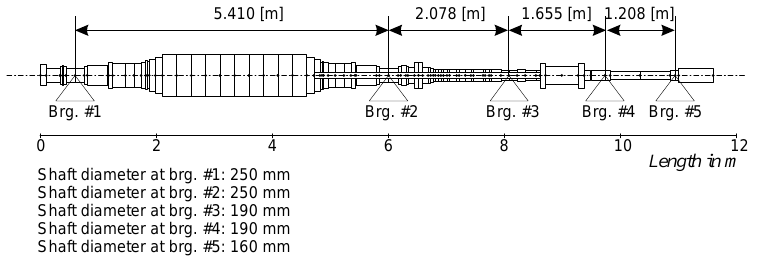
Fig. 4. Draft of the rotor-train: generator (between brg. #1 and #2), exciter (between brg. #2 and #3), flexible coupling (between brg. #3 and #4), slow shaft of the geabox (between brg. #4 and